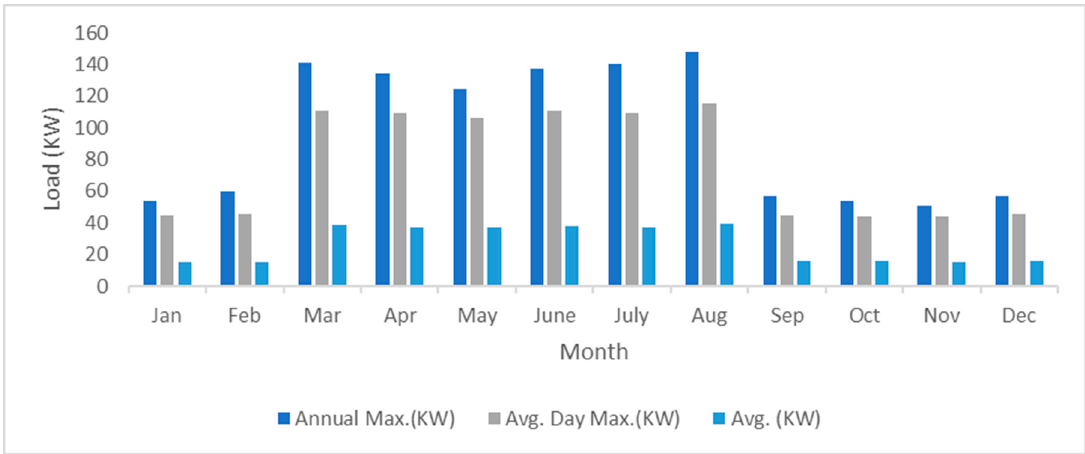
Figure 10. Monthly avg. inverter input and output (KW) .